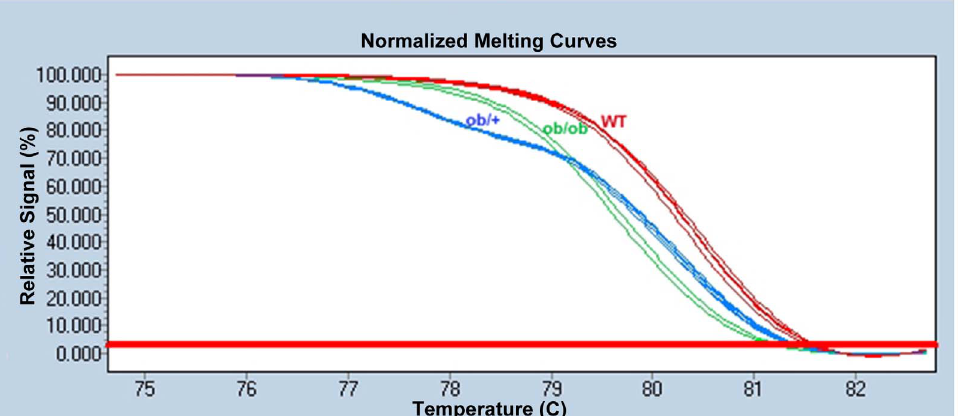
Figure 2. Fluorescence normalized high resolution melting curves of wild type (red), ob/ob (green), and ob/ + (blue) animals.